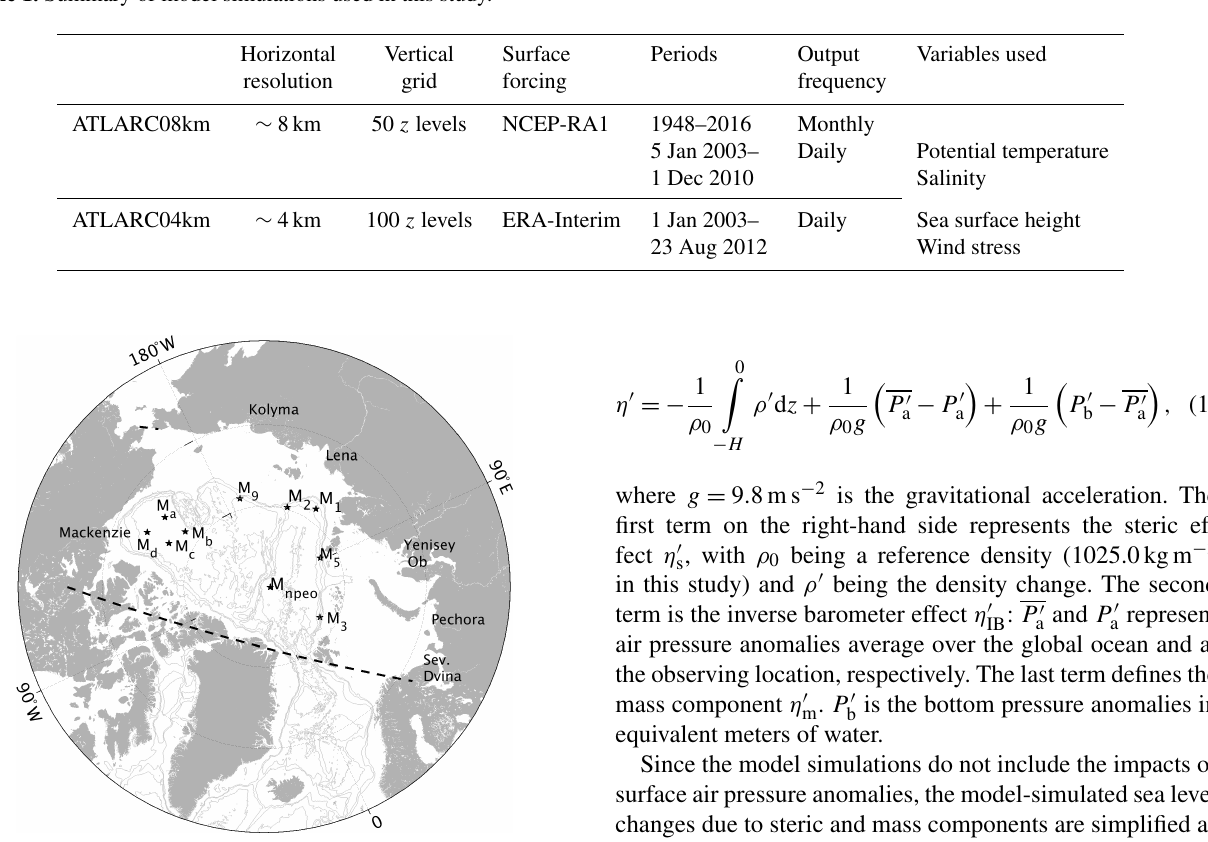
Table 1. Summary of model simulations used in this study.